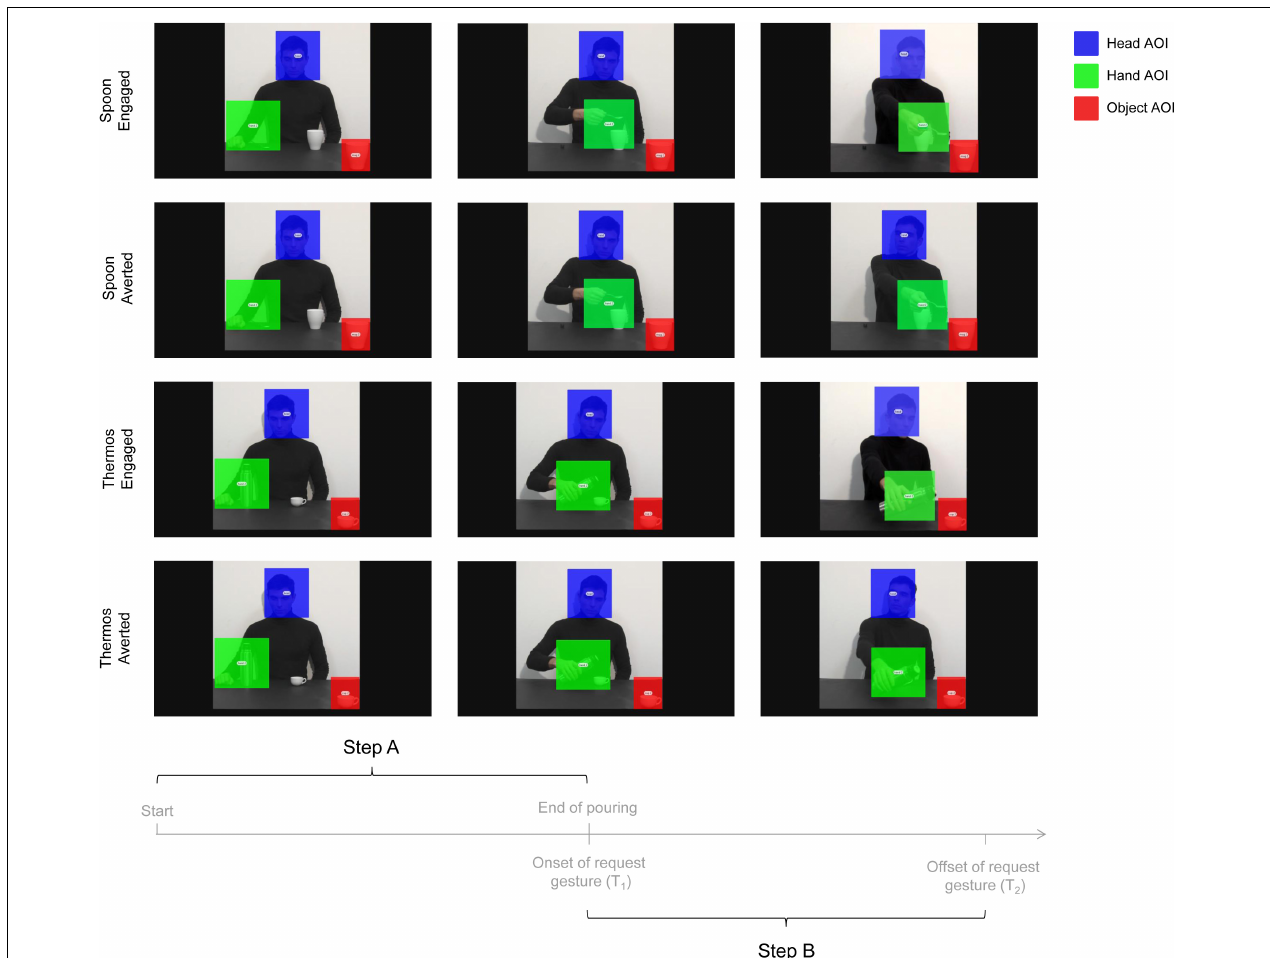
FIGURE 4 | Sequence of events for the four experimental videos (i.e., Engaged and Averted conditions with Spoon and Thermos actions) and the time epochs considered for data analysis (i.e., Step A and Step B). The overlaid colored rectangular areas represent the adopted AOIs: Head AOI (blue); Hand AOI (green); and Object AOI (red).